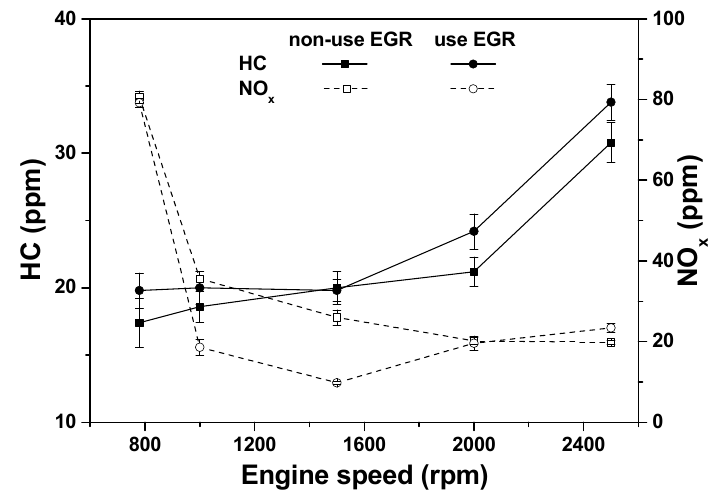
Figure 7. HC and NO x emissions with respect to the engine speed and use/non ‐ use of the exhaust gas recirculation (EGR) system.